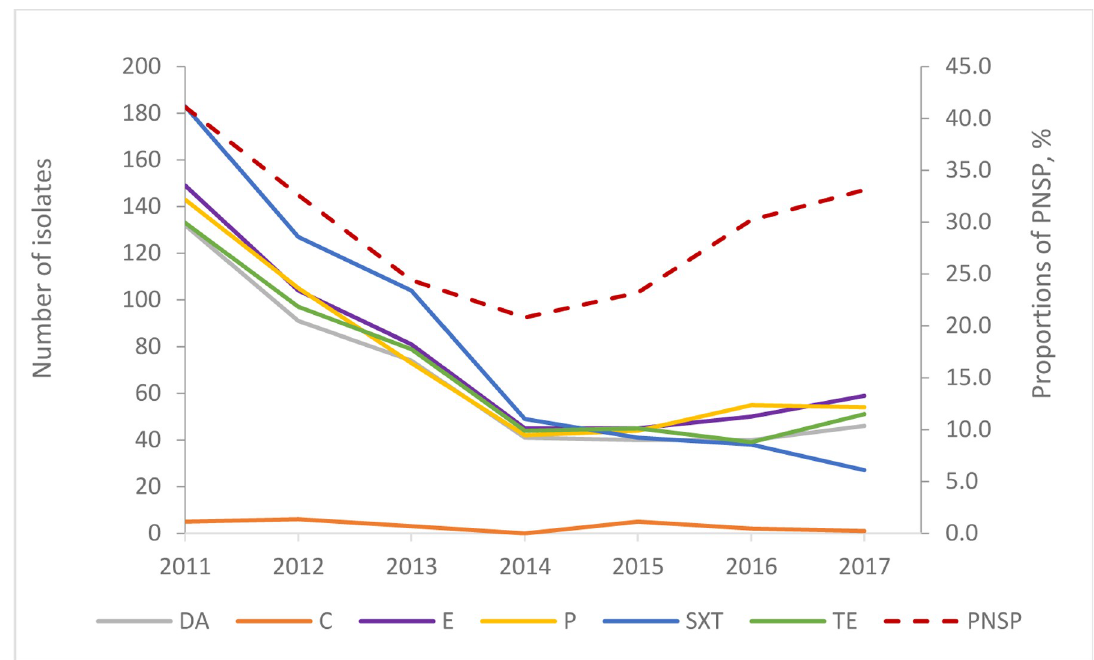
Fig 4. Annual number and proportions of non-susceptible pneumococcal isolates to routinely tested antimicrobials. Numbers of non-susceptible isolates to the antimicrobials are shown on the left Y-axis: clindamycin (DA) chloramphenicol (C), erythromycin (E), penicillin (P), trimethoprim/sulfamethoxazole (SXT) and tetracycline (TE).The proportions of PNSP of all pneumococci are shown in percentages on the right Y-axis (red dotted line).